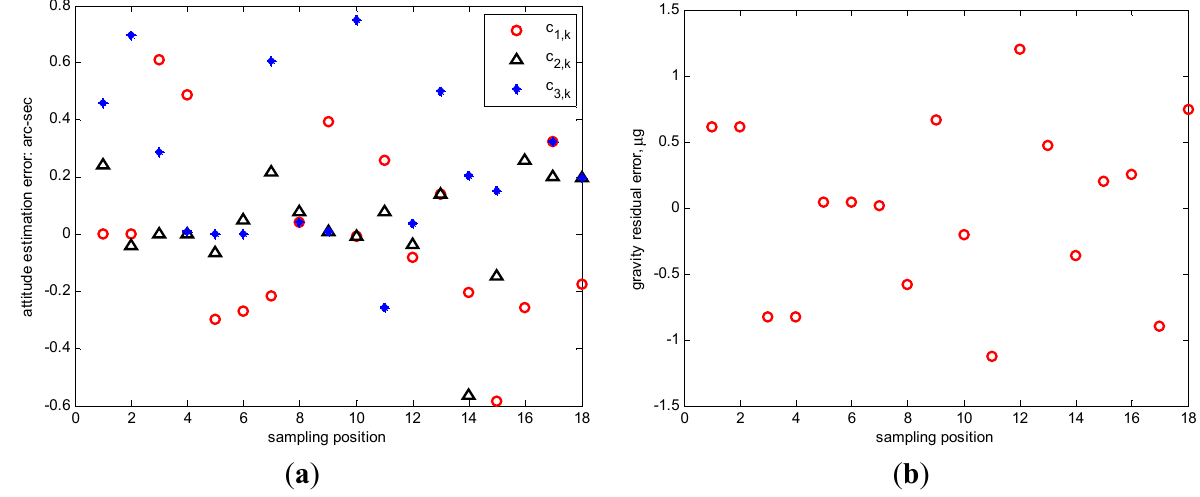
Figure 2. ( a ) The inclination vector estimation error; ( b ) The residual gravity error.